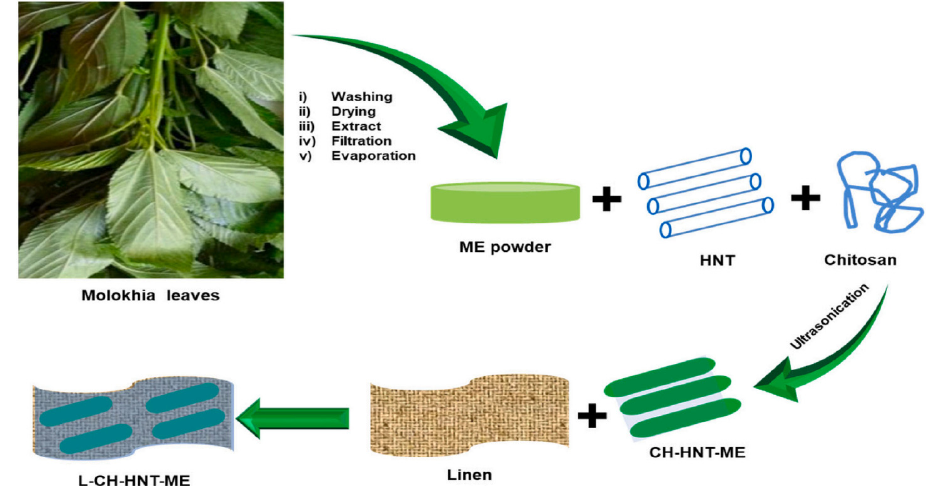
Figure 7. Schematic diagram representing the synthesis of green textile coating CH-HNT-ME and their linen textile fabric composite L-CH-HNT-ME. Reproduced with permission [58]. Copyright 2022, Elsevier.